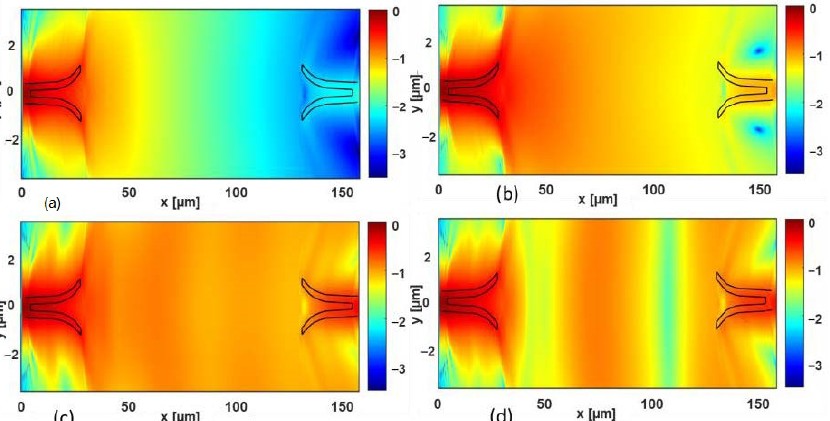
Figure 13. Normalized electric field (in logarithmic scale) calculated in the xy-vertical plane for z = 0 μm (i.e., in the middle of the antennas) for the TM polarization. The link distance is d link = 100 μm , and different values of the thickness d are considered, namely: ( a ) d = 0.5 μm, ( b ) d = 0.9 μm, ( c ) d = 3 μm, and ( d ) d = 4 μm. The antennas are denoted by the black lines. The wavelength is λ = 1.55 µm.